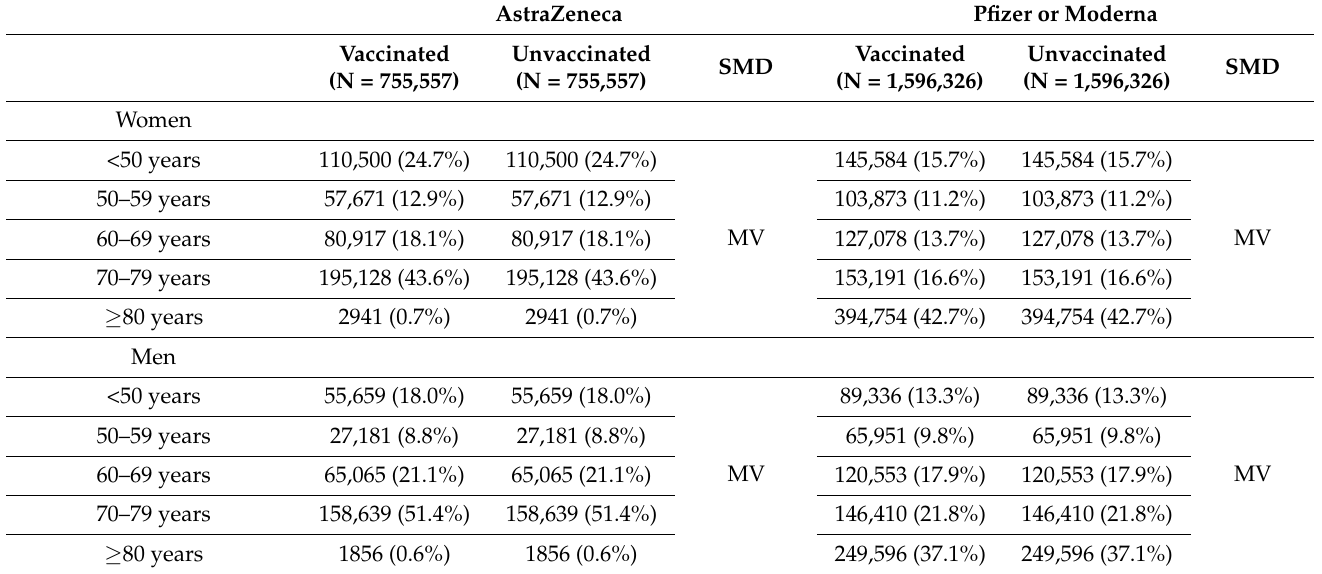
Table 1. Demographic and clinical characteristics of vaccinated and unvaccinated citizens at